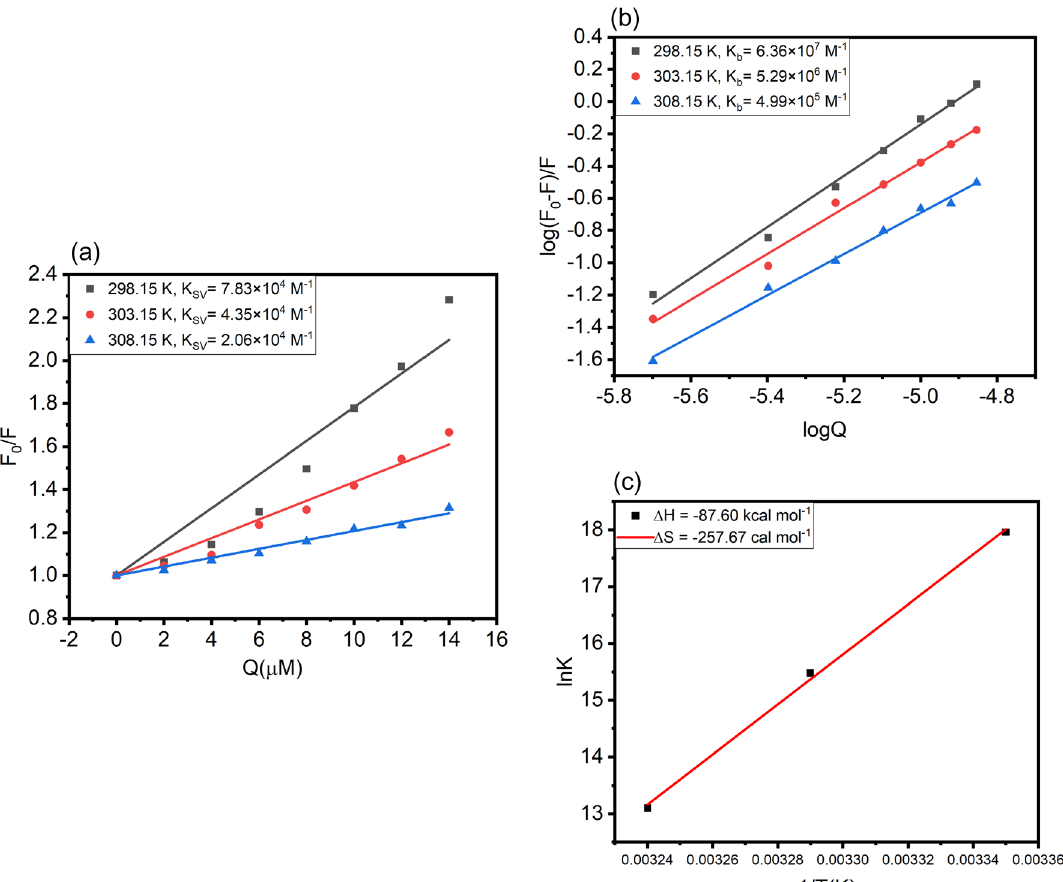
Figure 3. (a) Plot of F 0 /F versus Q for the calculation of Stern–Volmer quenching constant (K SV ), (b) plot of log (F 0 /F)/F versus log (Q) for the calculation of binding constant (K b ), (c) Van’t Hoff plot of lnK versus 1/T (K) for the calculation of thermodynamic parameters for HSA-T-res system, at 298.15, 303.15 and 308.15 K and pH